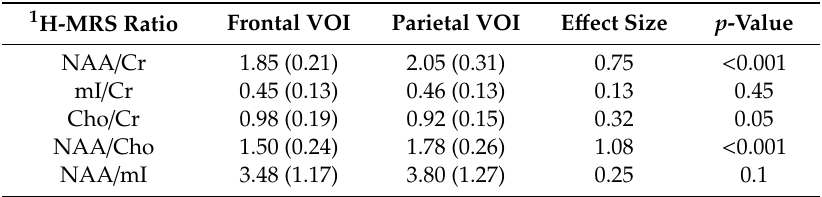
Table 3. 1 H-MRS ratios in the frontal and parietal